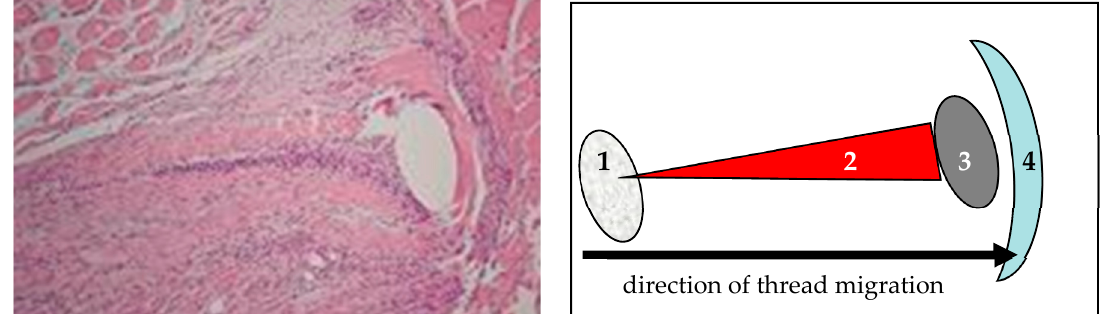
Figure 7. Comet’s tail phenomenon due to suture migrating through the abdominal wall in the direction of the incision [6,17]. (1) Original position of the thread; (2) comet’s tail consisting of tissue necrosis and inflammatory cells; (3) position of the thread at the time of cross section; (4) tissue necrosis due to compression.